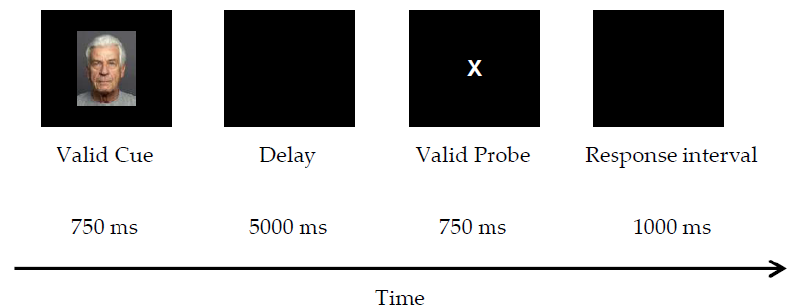
Figure 4. Sample trial procedure for a target trial in the face-cue AX-CPT (Experiment 2).